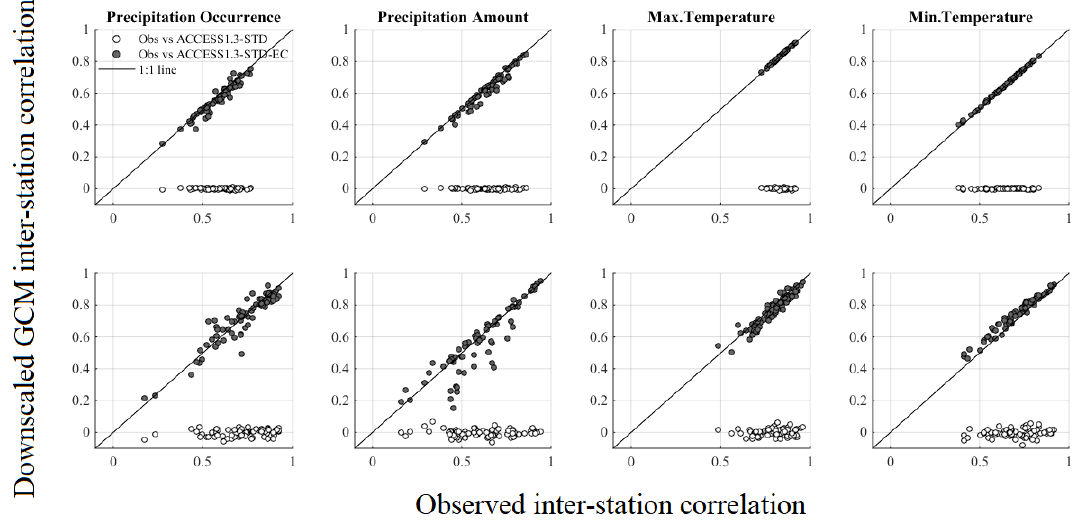
Figure 2. Inter-site Spearman rank correlations for precipitation occurrence, precipitation amount, maximum temperature, and minimum temperature for all possible station pairs and for all months for observations and spatially-temporally downscaled ACCESS1.3 data under RCP8.5 scenario over the period of 2071–2100. The four columns represent precipitation occurrence, precipitation amount, maximum temperature, and minimum temperature, respectively. The two rows denote the results for daily and monthly timescale, respectively. Median values across the 100 different simulations are shown against the observed